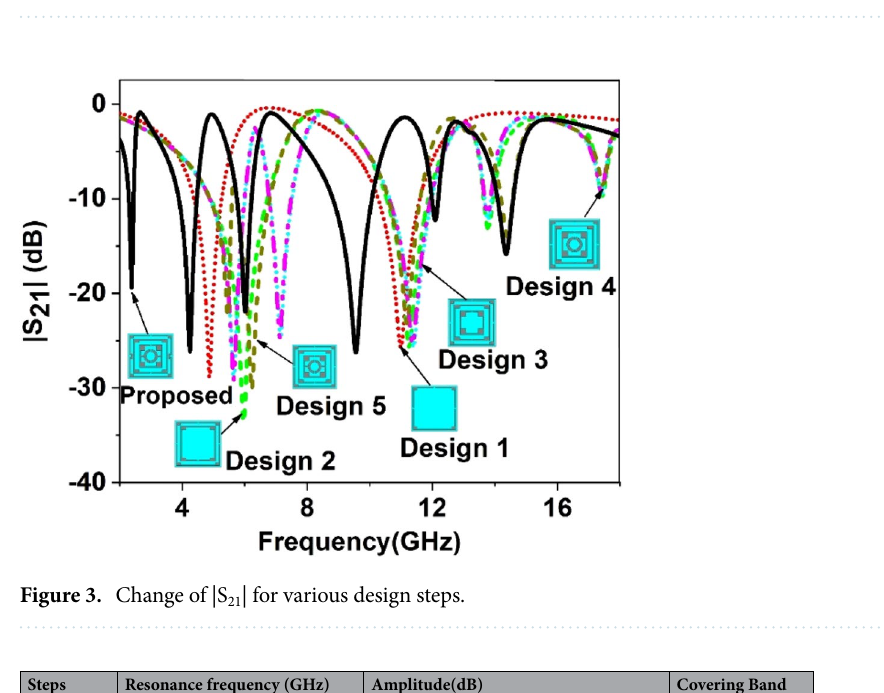
Figure 2. Simulation setup of the unit cell.